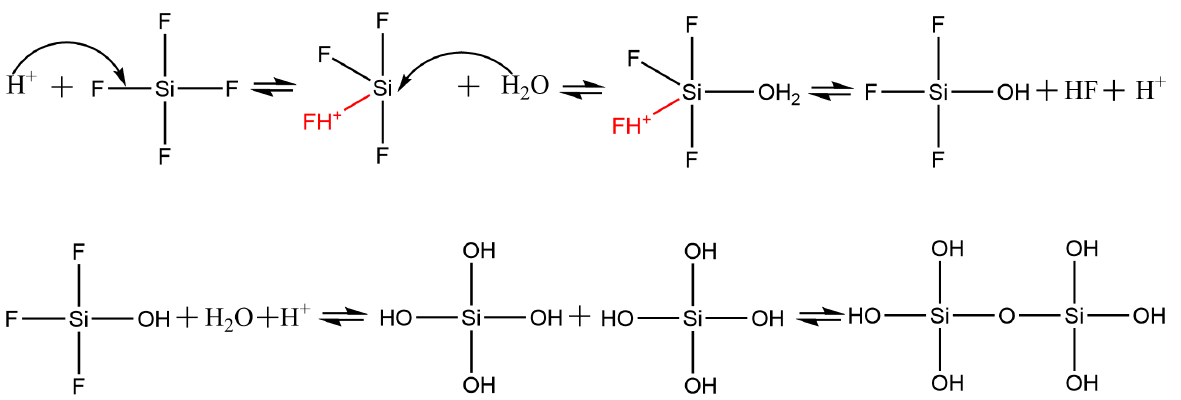
Figure 6. Reaction mechanism of silicon tetrafluoride hydrolysis.